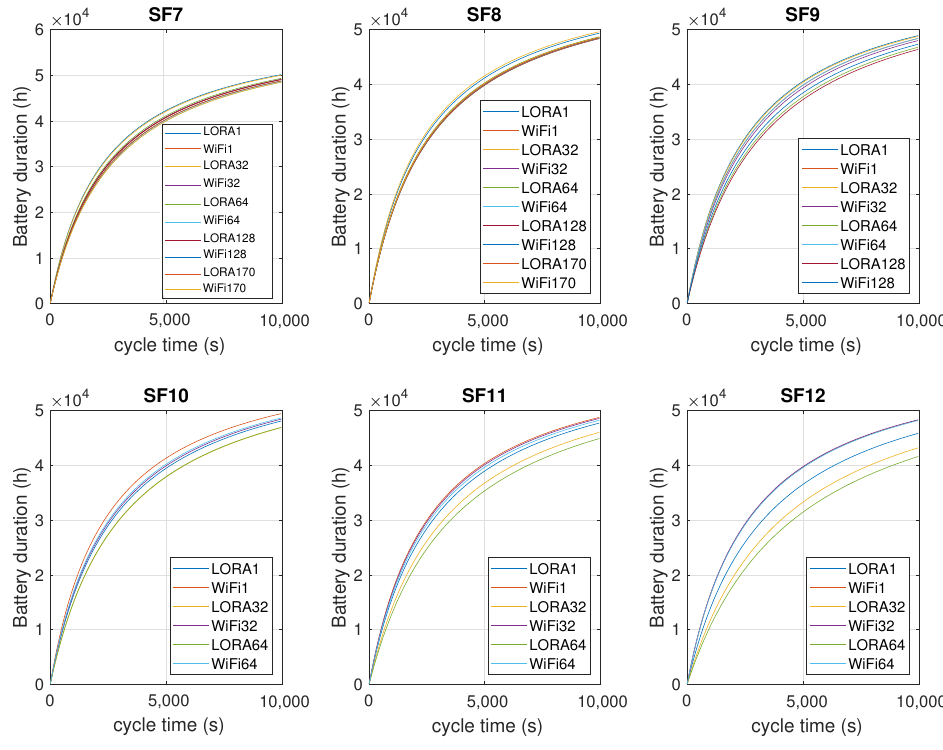
Figure 13. Battery duration for different cycle times and